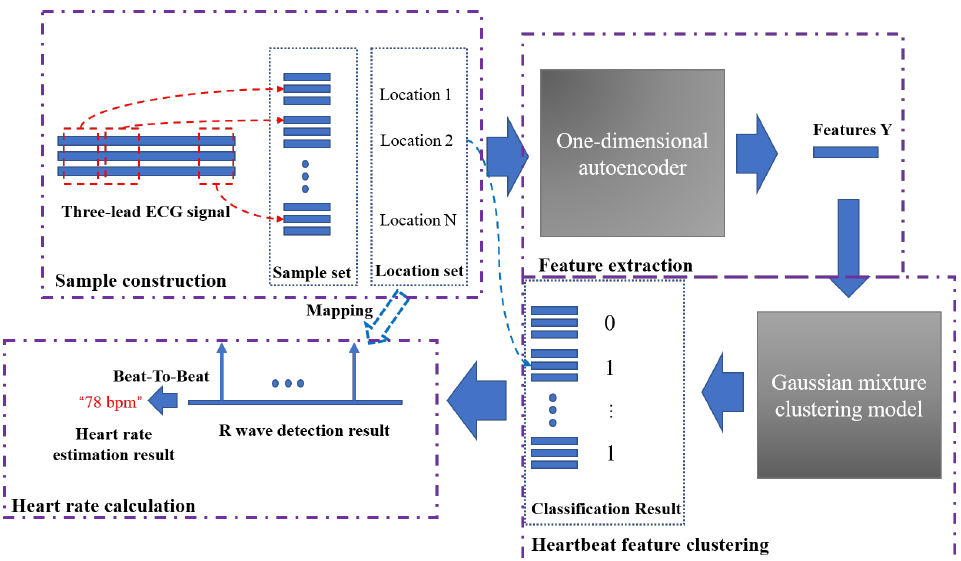
Figure 7. The complete heart rate estimation process of the AE-GMM method.